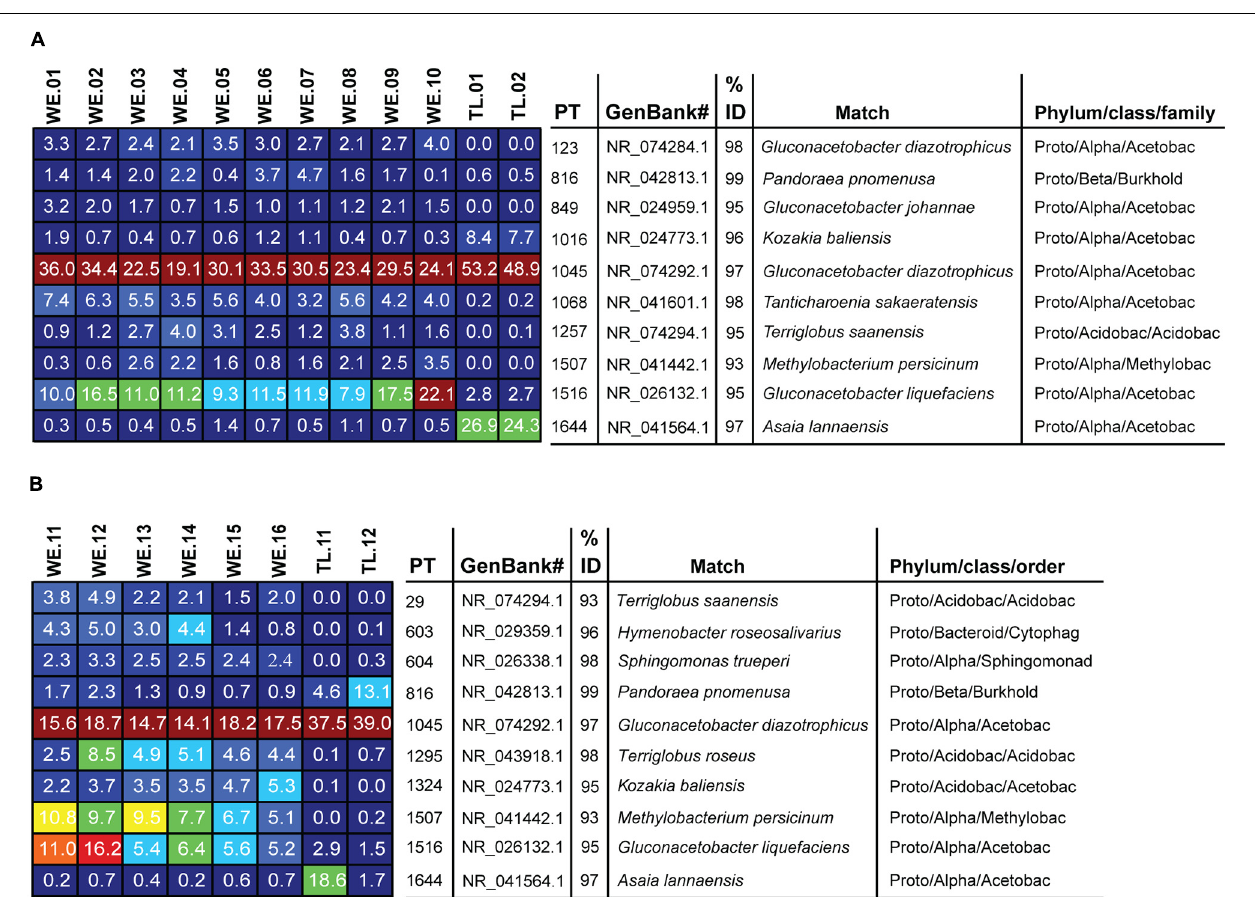
and occurred frequently in samples of a given conifer species. Abbreviations: PT = Phylotype, Acetobac = Acetobacteraceae , Acidobac